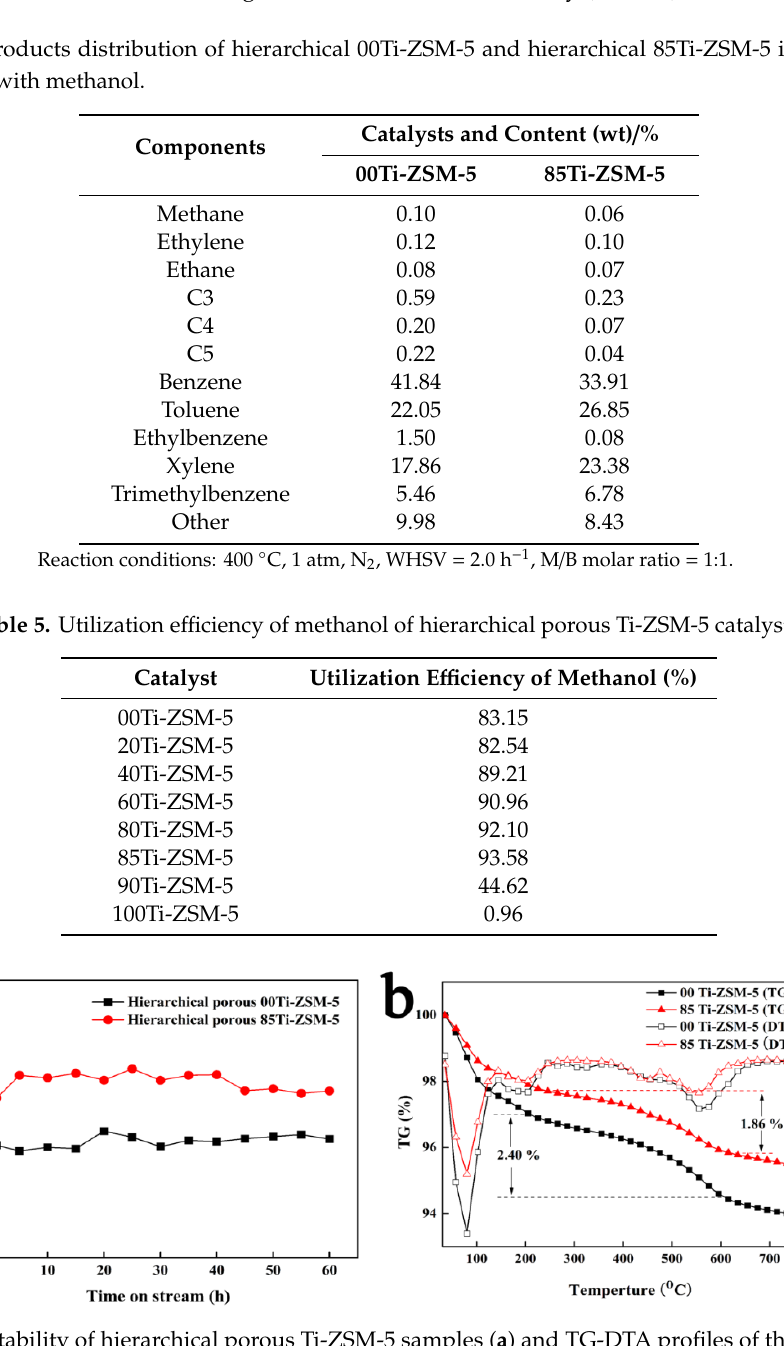
Figure 4. Stability of hierarchical porous Ti-ZSM-5 samples ( a ) and TG-DTA profiles of the catalysts after successive reaction ( b ).